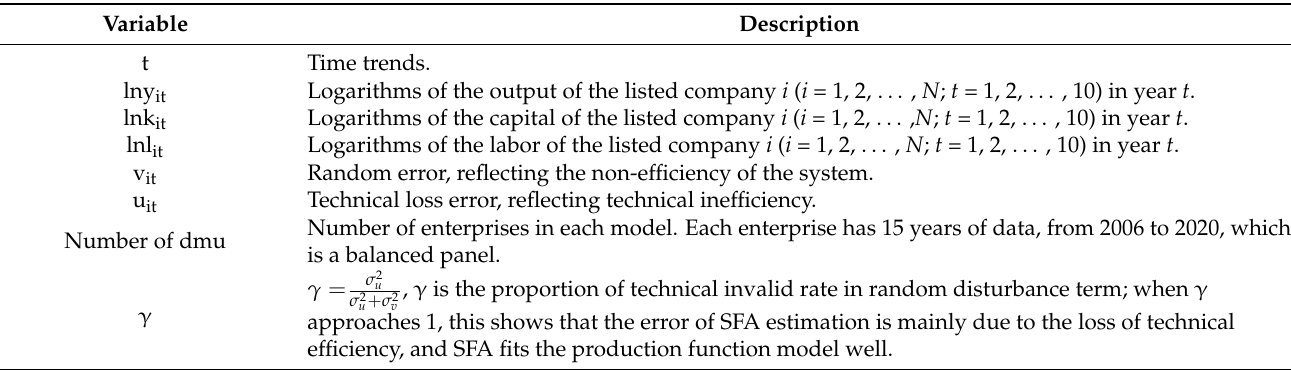
Table A4. Variables